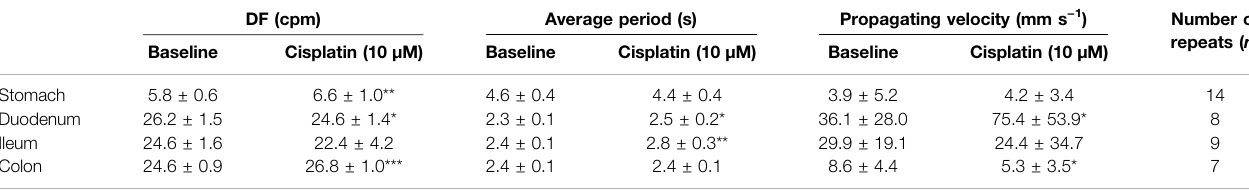
TABLE 2 | Effect of cisplatin (10 μ M) on the dominant frequency (DF), average period and propagating velocity, compared to